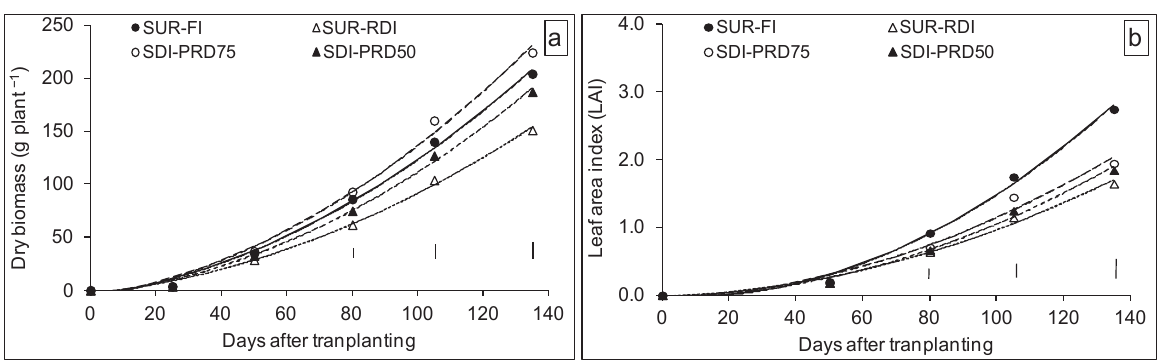
Fig. 4: Seasonal changes of dry biomass (a) and LAI (b) during the progress of growth season of tomato under different drip irrigation treatments. Data points are two years pooled data of three replications. Least significant difference (LSDs) at P ≤ 0.05 is presented as vertical line bars. FI = full irrigation; PRD = partial root zone drying; RDI = regulate deficit irrigation; SDI = subsurface drip irrigation; SUR = surface drip irrigation.